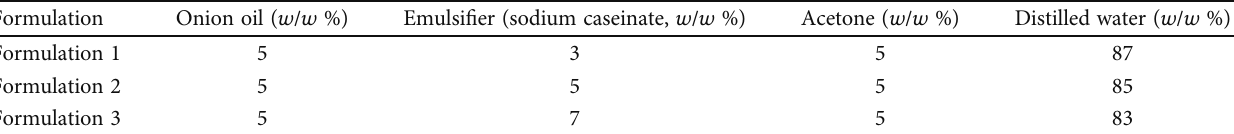
Table 1: The formulation of onion EO emulsions with di ff erent concentrations of sodium